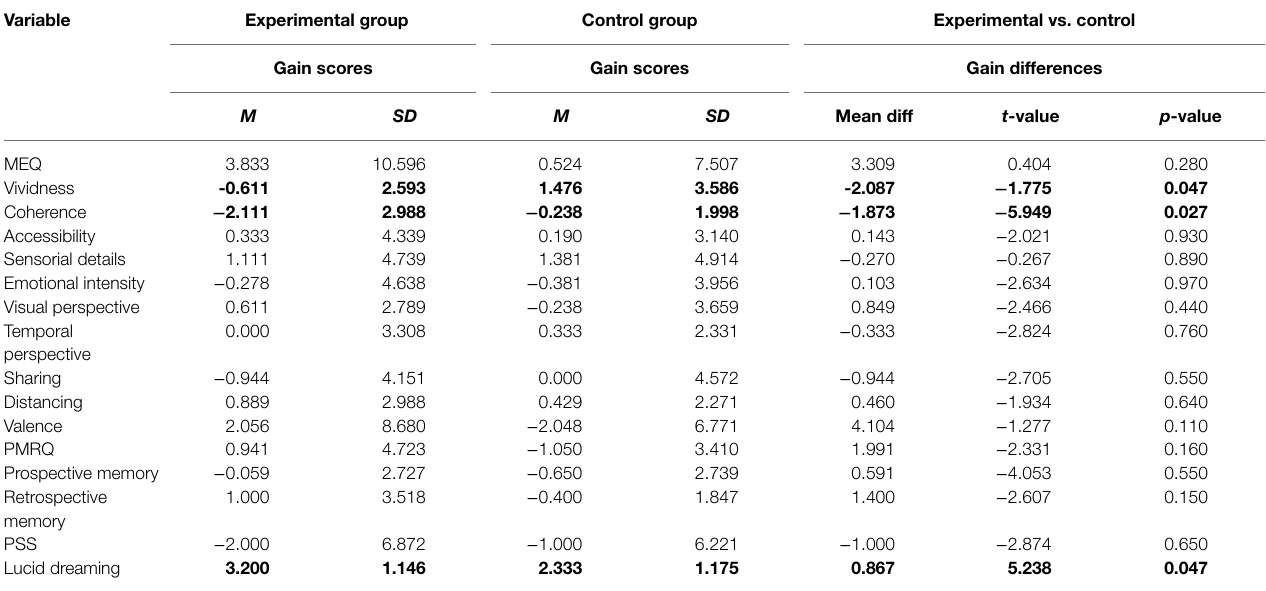
TABLE 1 | Gain scores (means M and SD) of metamemory measures, stress, and lucid dreaming self-assessments in the experimental group and the control group, and then, their differences tested with t -test permutation (false discovery rate, FDR corrected).